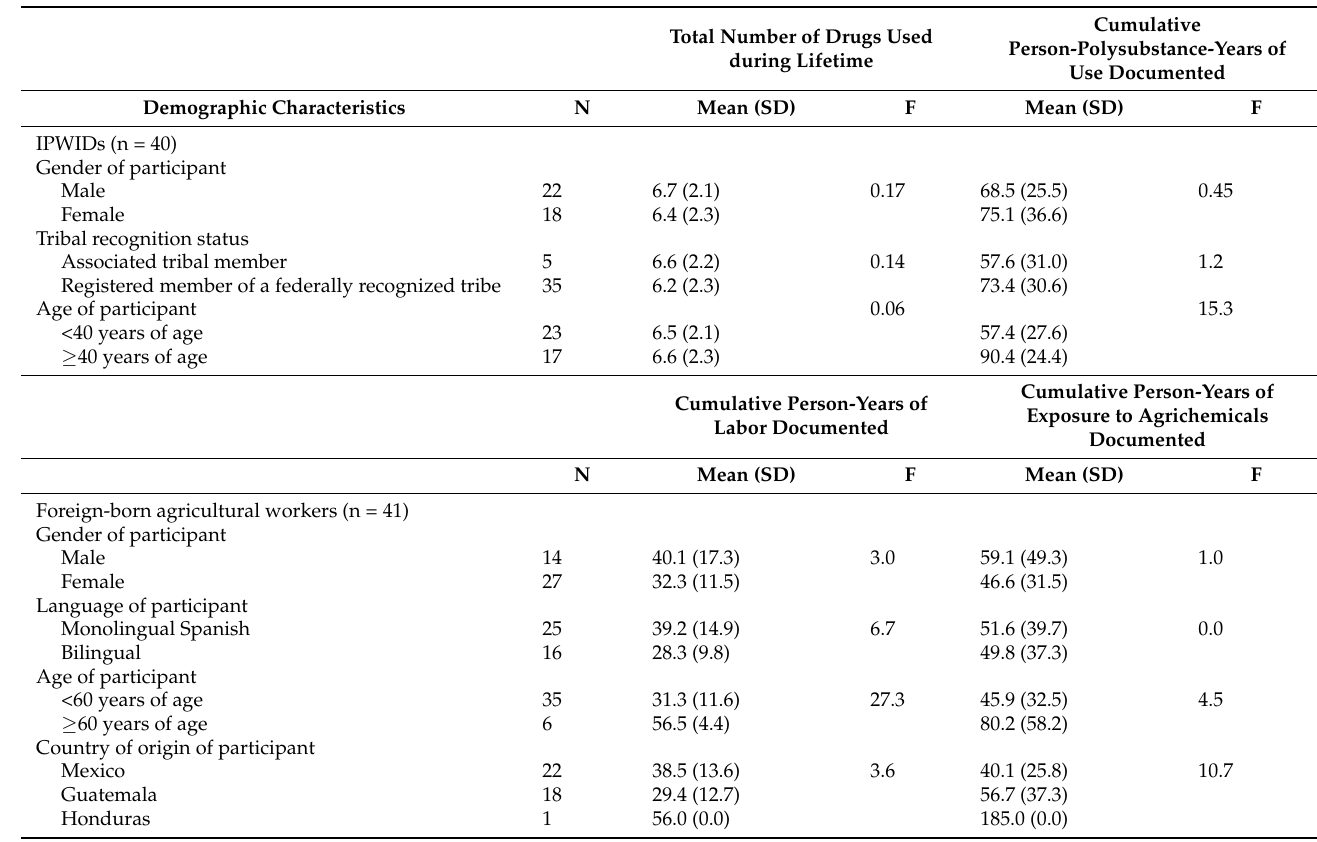
Table 2. Human–chemical interactions documented over the lifespan relative to the demographic characteristics of the participants of the two pilot studies, n =